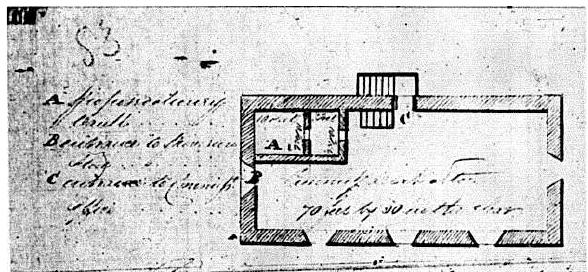
Figure 1. Sketch plan of Commissariat building, first floor, showing location of proposed treasury vault and dated: 15 February 1830. (Library and Archives Canada, R.G., 2, Vol.50,